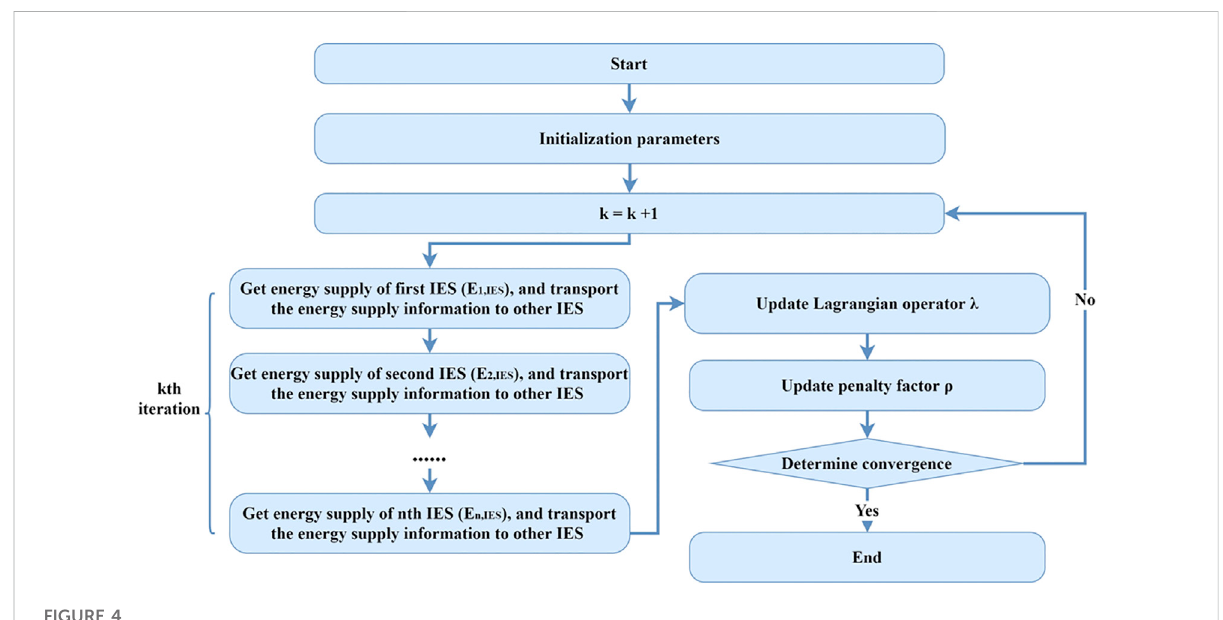
FIGURE 4 Distributed optimization fl ow